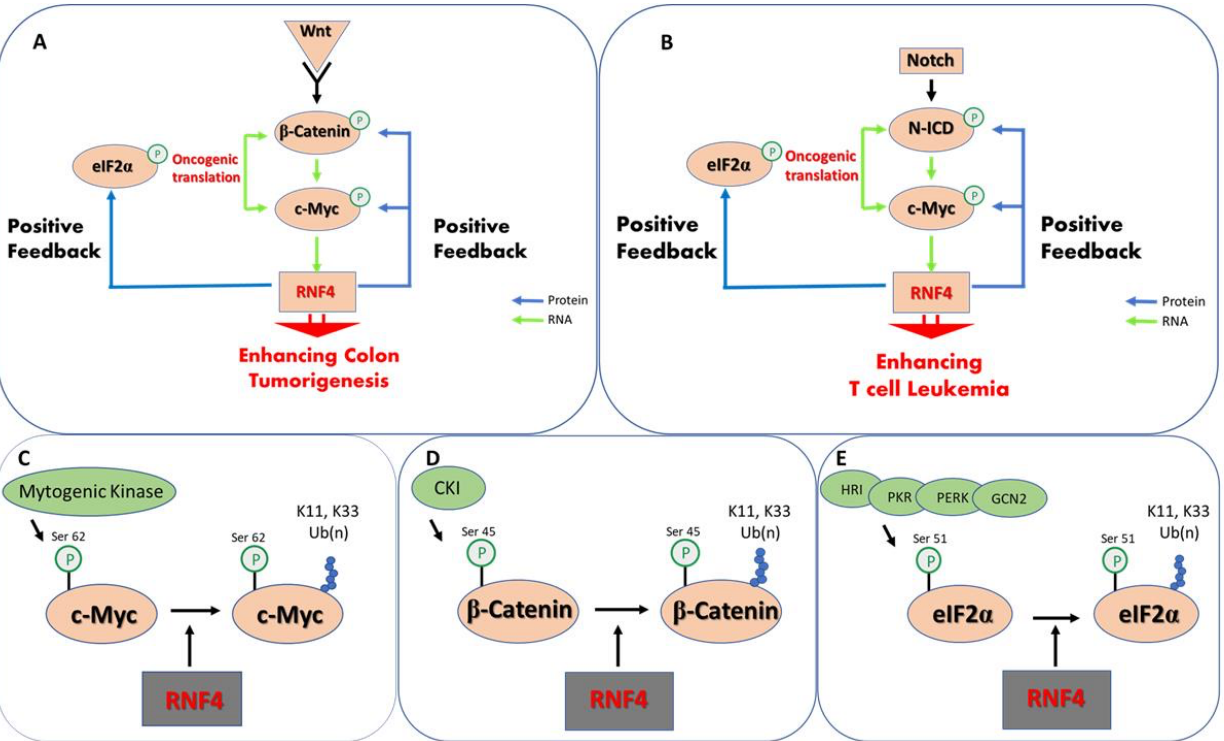
Figure 2. Protein stabilization is a feed-forward mechanism enhancing tumorigenesis. ( A ) In colon cancer activation of Wnt signaling results in the nuclear translocation of the β -catenin co-activator that together with TCF activates the transcription of c-Myc. c-Myc binds to the rnf4 gene and induces its expression. RNF4 protein in turn stabilizes both p (S45) - β -catenin and p (S62) -c-Myc and enhances their stability and transcriptional activity. In parallel, RNF4 stabilizes p (S51) eIF2 α that is central for the activation of oncogenic translation including c-Myc and VEGF. ( B ) A similar mechanism operates in acute T-cell leukemia, where Notch pathway activation induces the nuclear accumulation of Notch intracellular domain protein (N-ICD) that binds to a c-Myc enhancer inducing c-Myc expression, that subsequently increases RNF4 expression. ( C – E ) Molecular details of kinases and site of phosphorylation of the indicated oncoproteins that prime for RNF4-dependent K11, K33 polyubiquitination and protein stabilization.